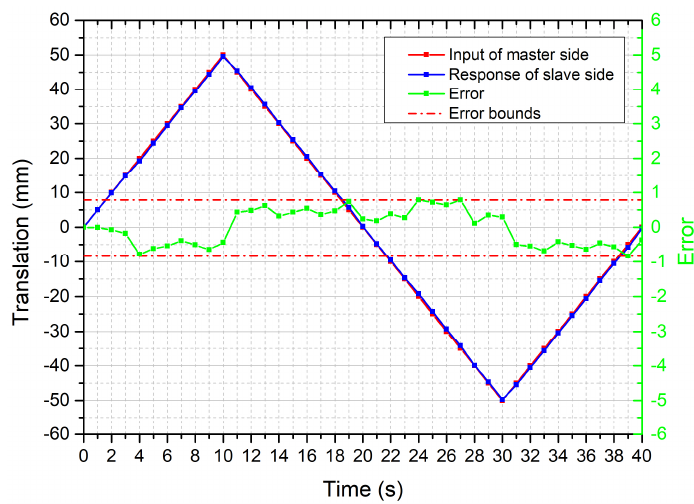
Figure 9. Results for the axial motion transmission.